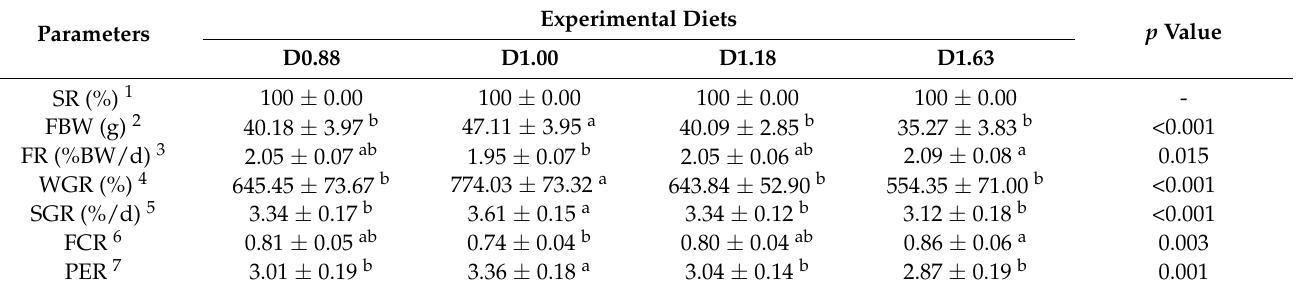
Table 3. Growth performance of Chinese soft-shelled turtle fed four experimental diets containing different phosphorus levels for 60 days.